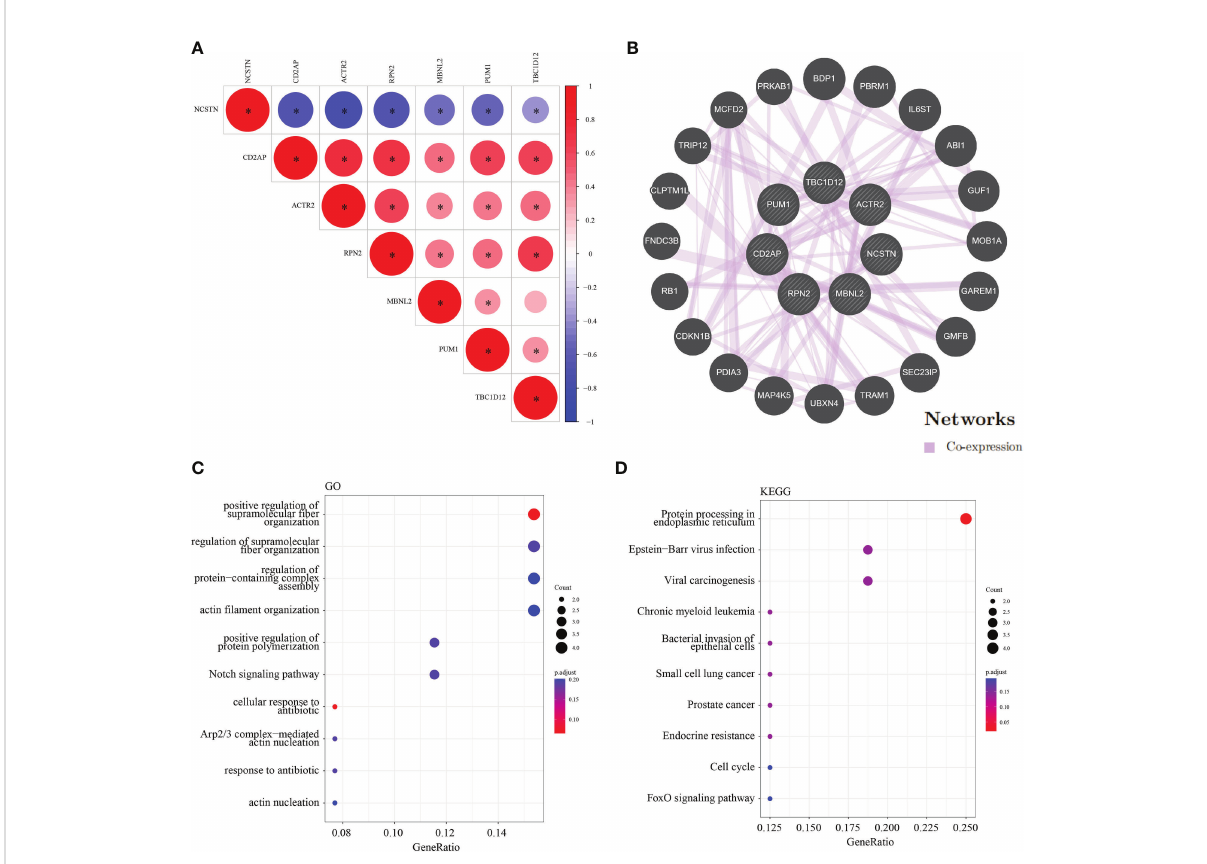
FIGURE 9 Co-expression and interaction analysis of the target genes. (A) Target gene co – expression network in GSE165004. (B) Target gene co – expression network in GeneMANIA database. (C) GO analysis of co – expressed genes. (D) Co – expressed gene KEGG analysis. *p <